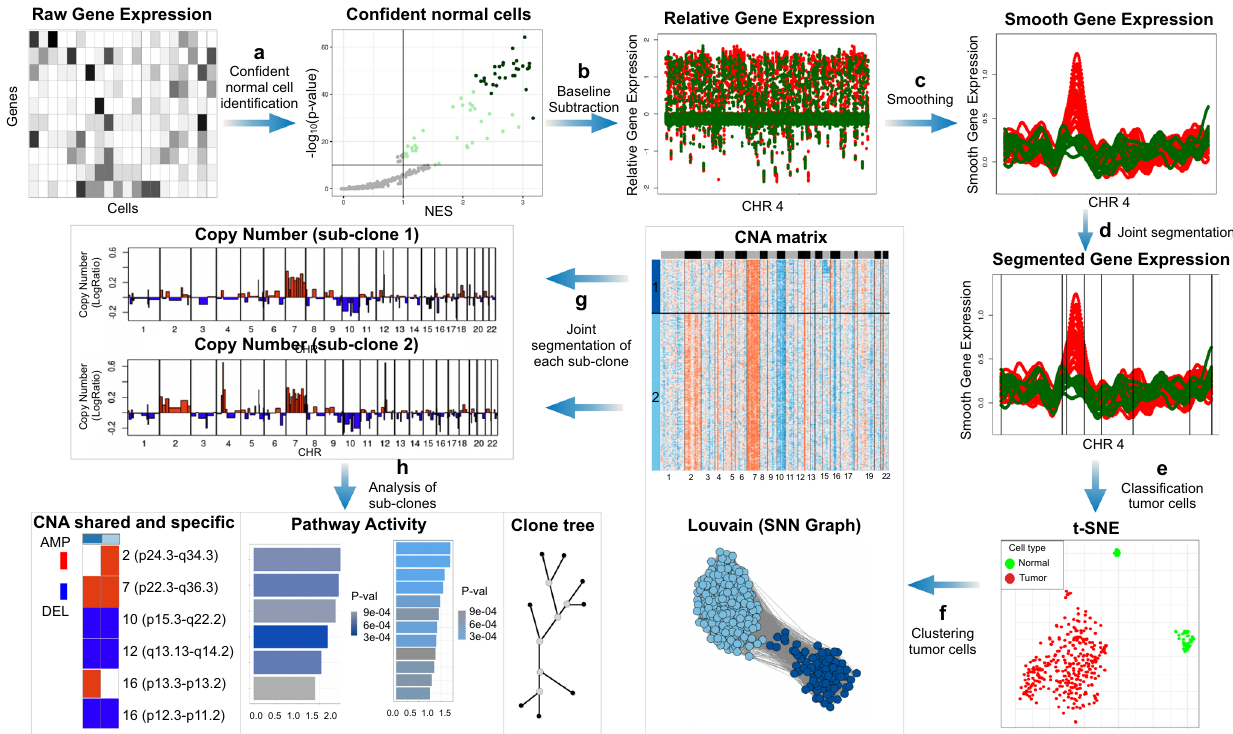
Fig. 1 | SCEVAN Work fl ow. SCEVAN starts from the raw count matrix removing irrelevant genesand cells. a Identi fi cation of a small setofhighlycon fi dent normal cells. b Relative gene expression obtained from removal of the baseline inferred from con fi dent normal cells. c Edge-preserving nonlinear diffusion fi ltering of relative gene expression. d Segmentation with a variational region-growing algo- rithm. e Identi fi cationofnormalcellsasthoseintheclustercontainingthemajority of con fi dent normal cells. f Identi fi cation of possible subclones using Louvain